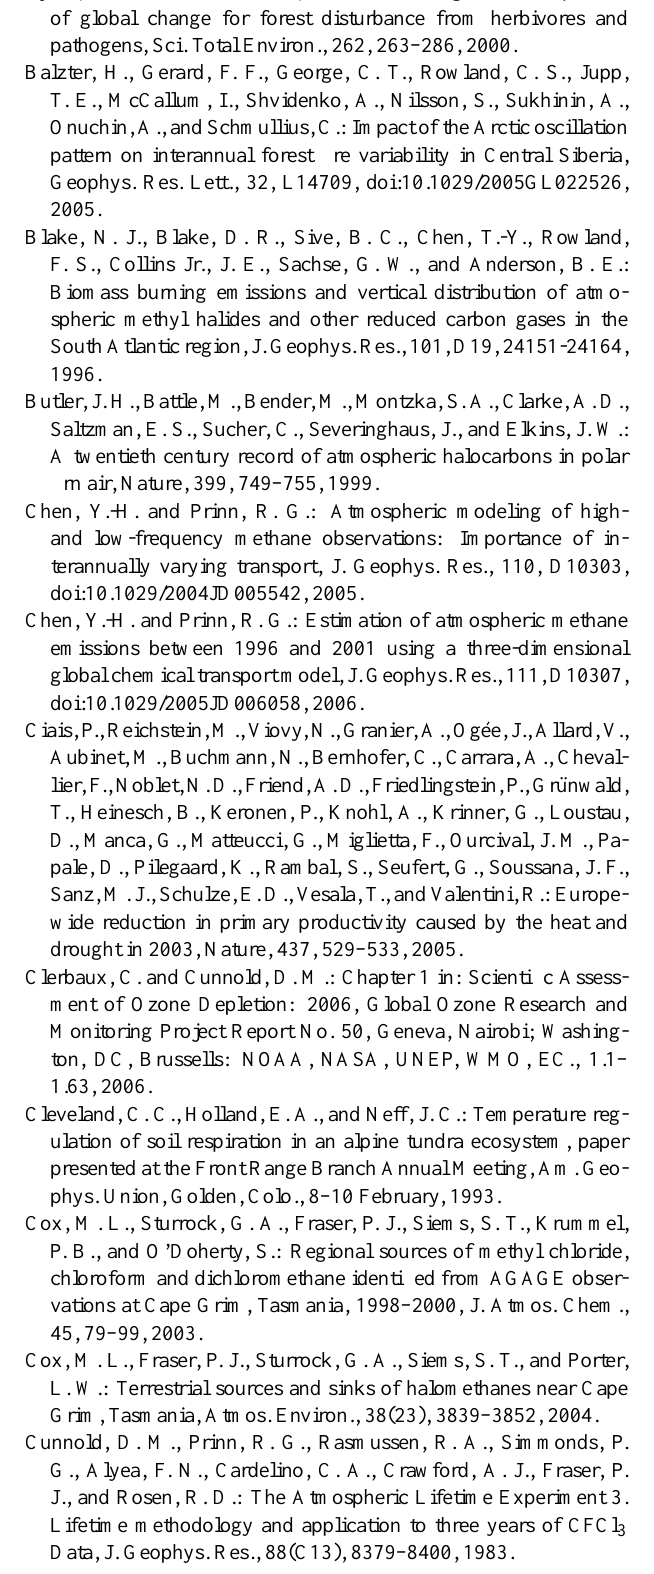
Table 3 Footnote #1, the last word: Figures -> figures (f not capital) Table 4 Footnote #1, the last word: Figures -> figures (f not capital) The following is Eq. (A8). Because my equation editor does not distinguish vector ( X ) and matrix ( I ), I set X as function style and defined function as bold and